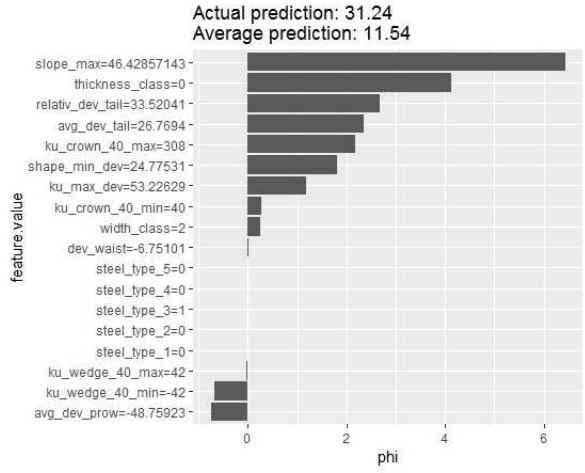
Figure 10: SHAP values for a bad product with a prediction of 31.24, while the average prediction is 11.54 inside the group of